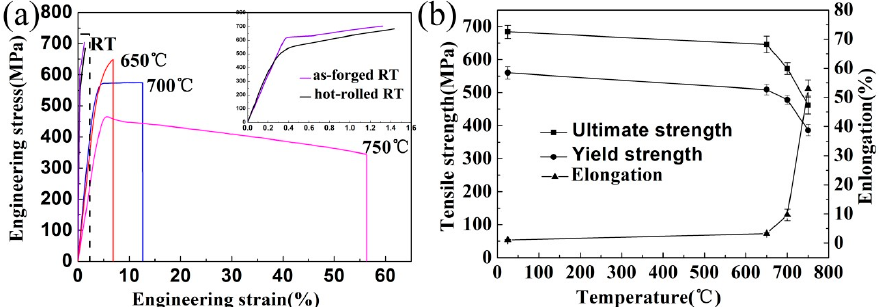
Figure 11. Tensile properties of the TiAl alloy: ( a ) tensile curves of the hot-deformed TiAl alloys; ( b ) the tensile-property variation of TiAl alloy sheet with increasing temperature.